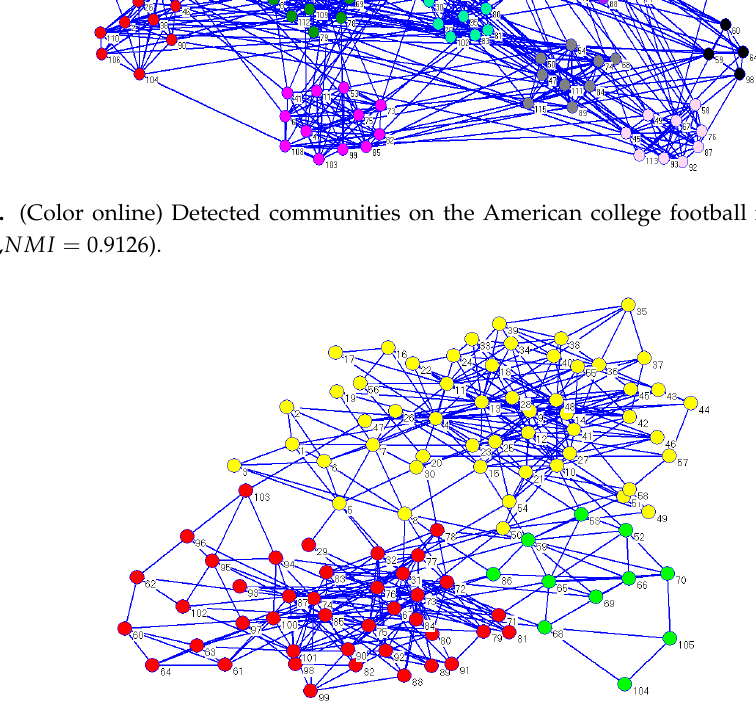
Figure 8. (Color online) Detected communities on the American political books network (when λ = 0.41, NMI = 0.5745).